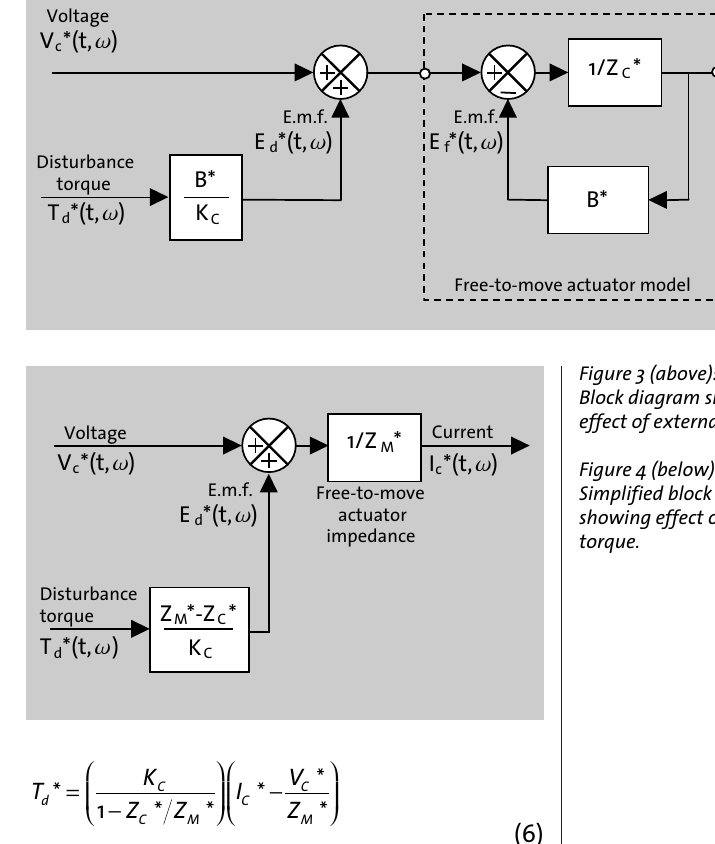
Figure 3 (above): Block diagram showing effect of external torque. Figure 4 (below): Simplified block diagram showing effect of external